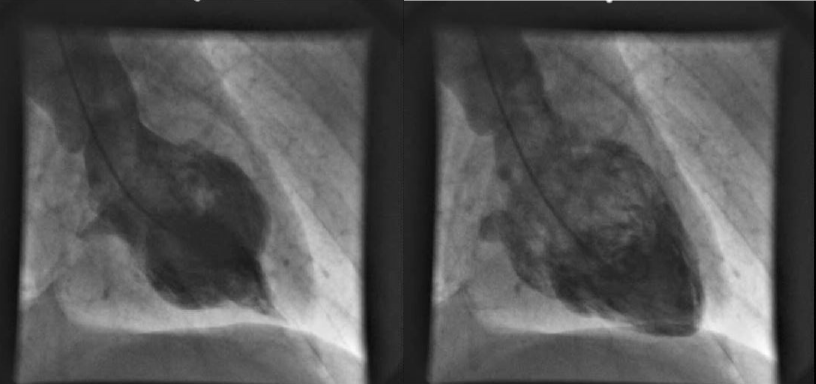
Figure 1. A representative sample of a female patient presenting a midventricular TTS form with no wall-motion abnormalities of the apex. Table 2. In-hospital events and treatment strategies in patients suffering from takotsubo cardiomy- opathy (TTS) and KF compared to patients with myocardial infarction and kidney failure. Variables Life-threatening